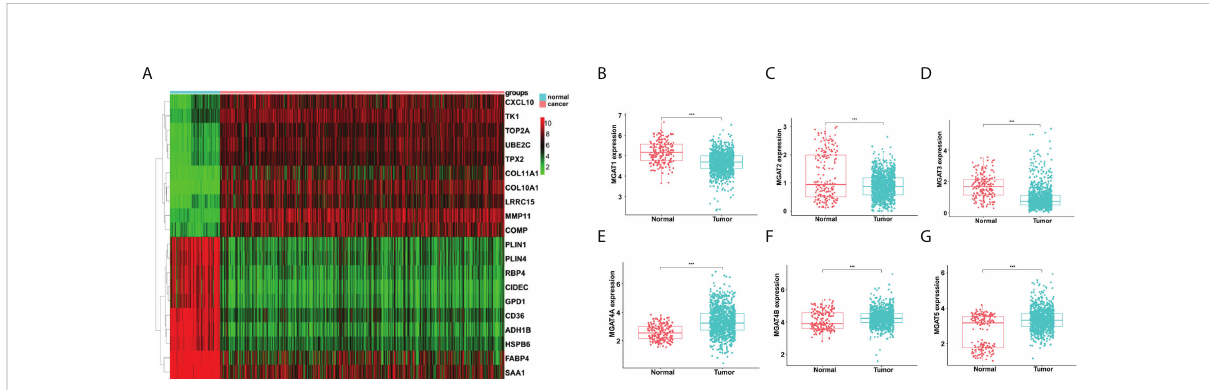
FIGURE 1 Analyses of gene expression differences in breast cancer and normal mammary tissues from the TCGA and GTEx databases. (A) Heatmap of top 20 DEGs. Comparisons of MGAT1 (B) , MGAT2 (C) , MGAT3 (D) , MGAT4A (E) , MGAT4B (F) and MGAT5 (G) expressions between breast cancer and normal tissues. *** means p<0.001.